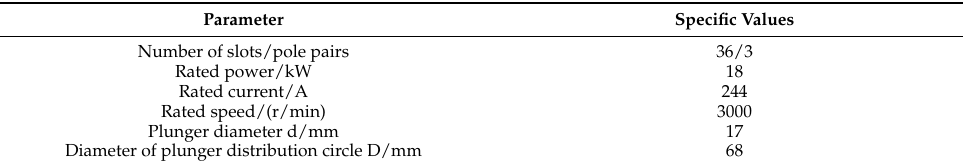
Figure 3. Radial electromagnetic force variation: ( a ) 0.01 s changes with space angle; ( b ) change in time at a point on the stator tooth end. The FFT (fast Fourier transform) decomposition of the radial electromagnetic force density with a space at 0.01 s and the radial electromagnetic force density with time at a point on the stator tooth end is shown in Figure 4a,b. The spatial order of the radial elec- tromagnetic force is mainly distributed at order 0, order 6, order 12, etc., and the variation in time–frequency is mainly distributed at 0, 350 Hz, 700 Hz, 1050 Hz, etc., which is con- sistent with the results obtained by the analytical method.